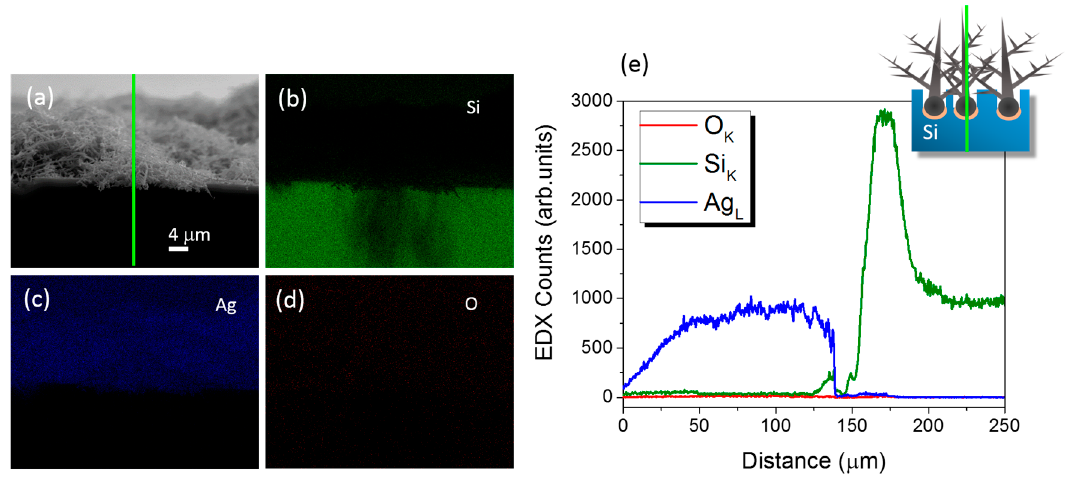
Figure 3. Compositional characterization. Energy dispersive X-ray spectroscopy (EDX) compositional maps of the ( b ) Si (in green), ( c ) Ag (in blue) and ( d ) O (in red) X-ray signals in comparison to ( a ) the SEM cross-section of stored Ag dendrites. ( e ) The EDX elemental profiles acquired for Si, Ag and O X-ray emission lines along the green line reported in ( a ) are also shown.